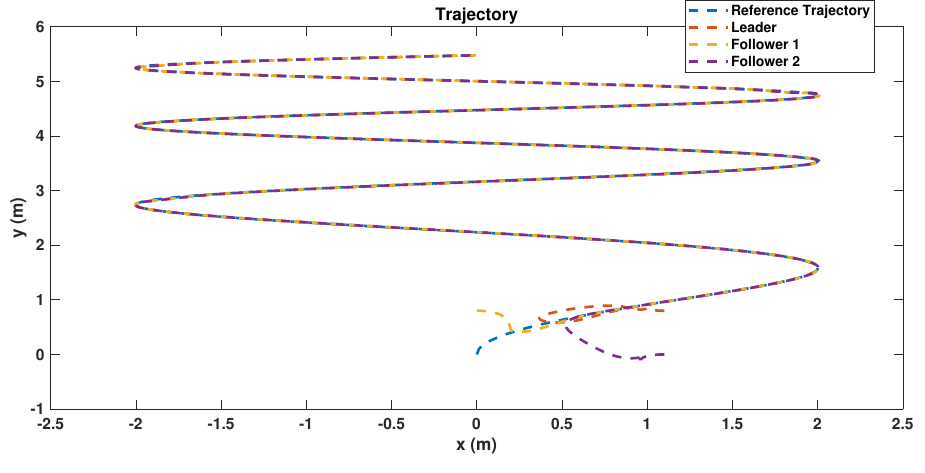
Figure 13. Path 3: The tracking performance.